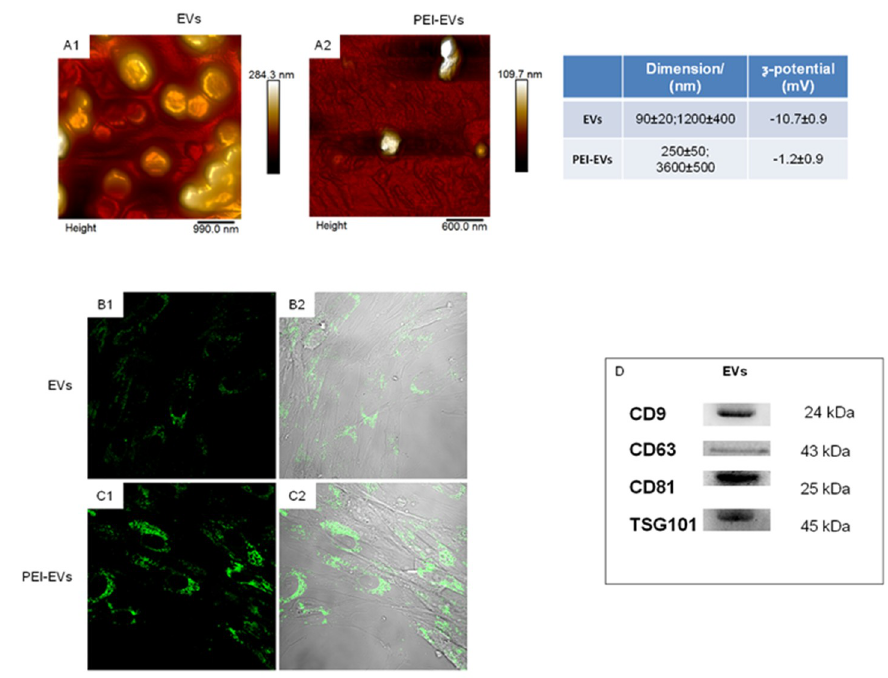
Figure 2. Extracellular vesicle (EV) and polyethyleneimine (PEI)-engineered EV (PEI-EV) characterization. ( A1 , A2 ) Atomic force microscopy pictures of EVs and PEI-EVs. ( Table ) Average size and ζ -potential of EVs and PEI-EVs. ( B1 , B2 ) Confocal laser scanning microscopy observations of fluorescent stained EVs cultured with GMSCs. ( C1 , C2 ) Confocal laser scanning microscopy observations of fluorescent stained PEI-EVs cultured with GMSCs. ( D ) Western blot showing the positivity for CD9, CD63, CD81 and TSG101. figure published in reference [9].